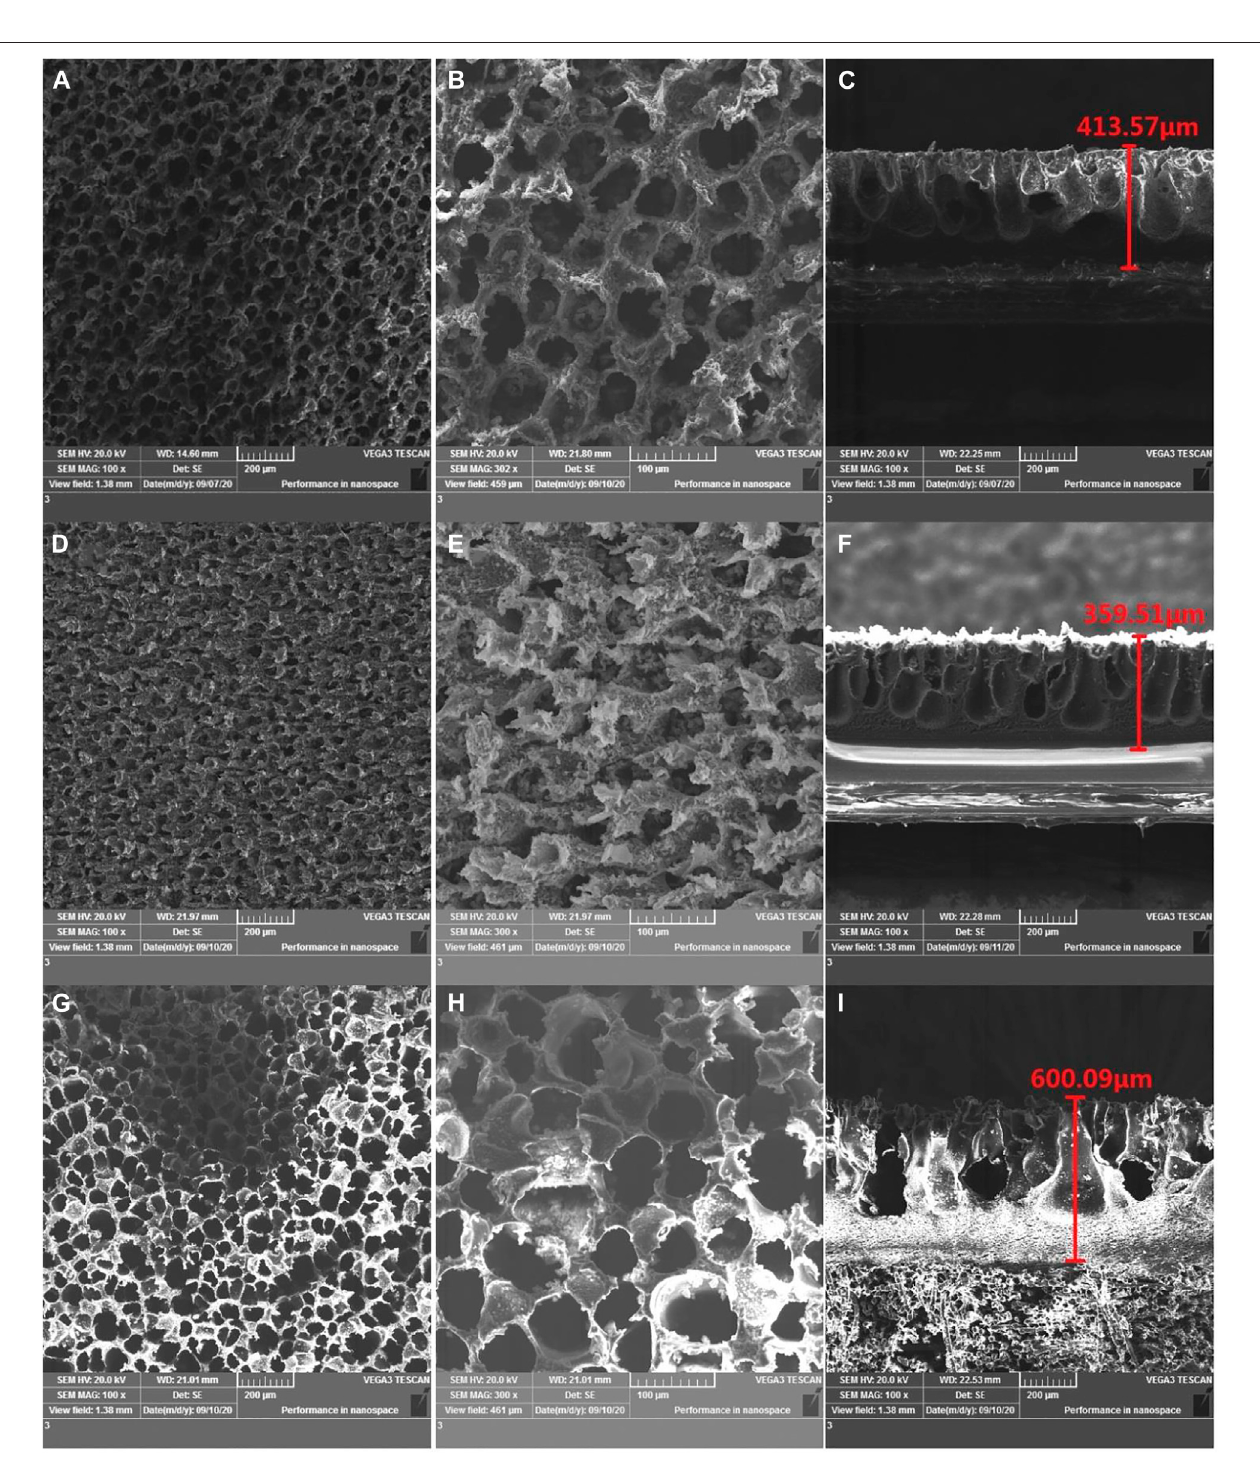
FIGURE 2 | SEM morphology images of the three polishing pads: (A) plane and (C) cross-sectional views of pad A; (D) plane and (F) cross-sectional views of pad B; (G) plane and (I) cross-sectional views of pad C. (B) , (E) and (H) are the enlarged views marked with the typical pore sizes for pads A, B, and C, respectively.